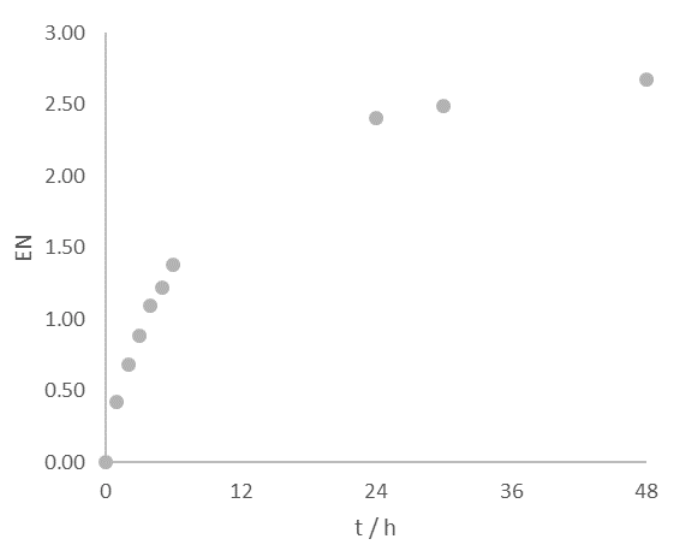
Figure 4. EN measured by NMR as a function of reaction time.